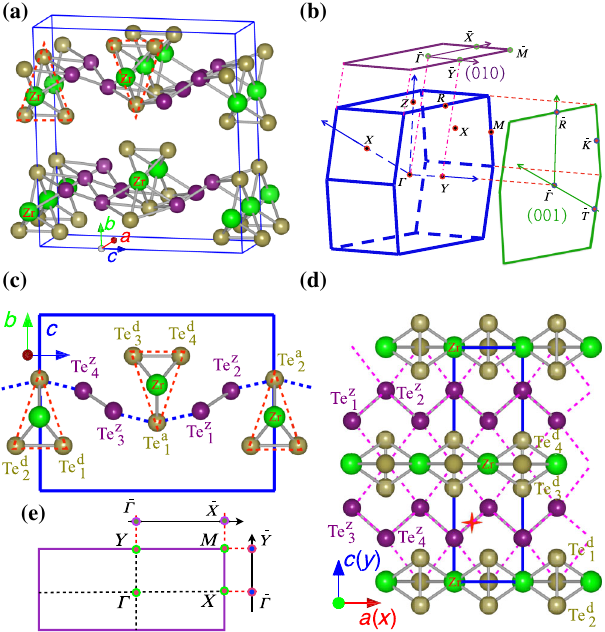
FIG. 1 (color online). (a) The crystal structure. (b) The bulk Brillouin zone (BZ) and the projected surface BZ of 3D ZrTe 5 (HfTe 5 ). (c), (d), and (e) The side view, top view, and BZ of the single-layer structure, respectively. In (d), the inversion center is indicated by the red star symbol, and the waved grid of the Te square lattice sheet is shown by the pink dotted lines.